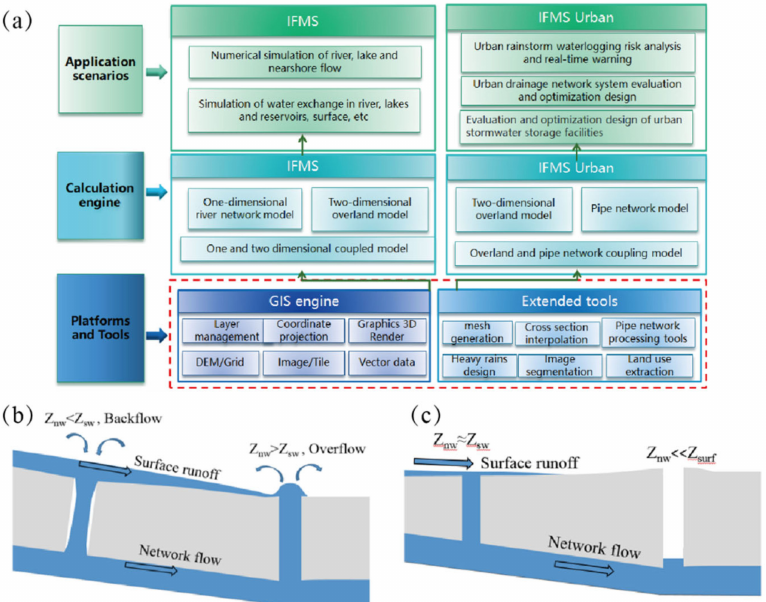
Figure 7. Diagram of model. ( a ) Framework diagram of the model; ( b ) overflow and backflow; ( c ) no flow